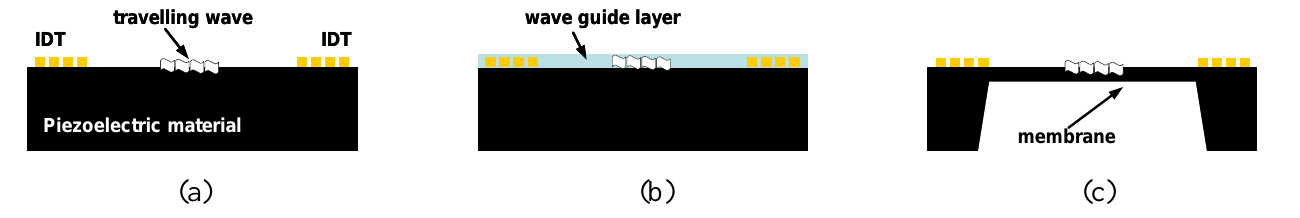
Figure 2. Different types of SGAW devices: (a) typical SAW configuration, (b) Love-wave SGAW device and (c) flexural plate SGAW